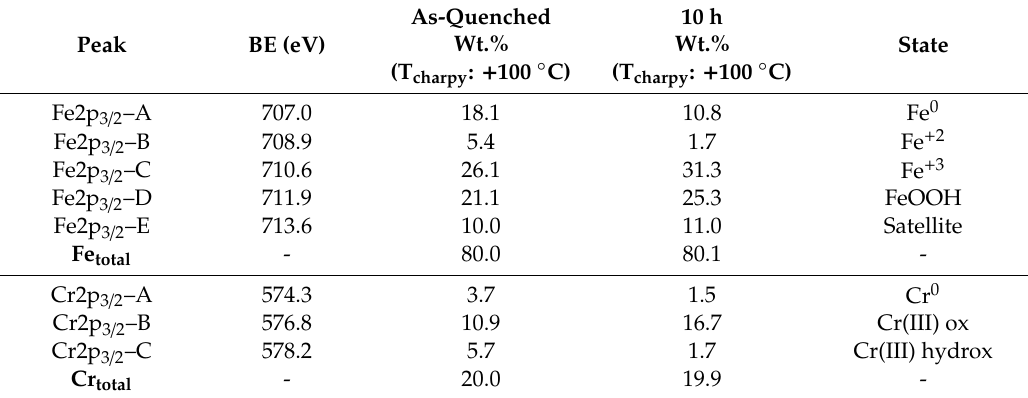
Table 5. Binding energy, XPS quantification, and chemical states of Fe and Cr of the samples broken in ductile